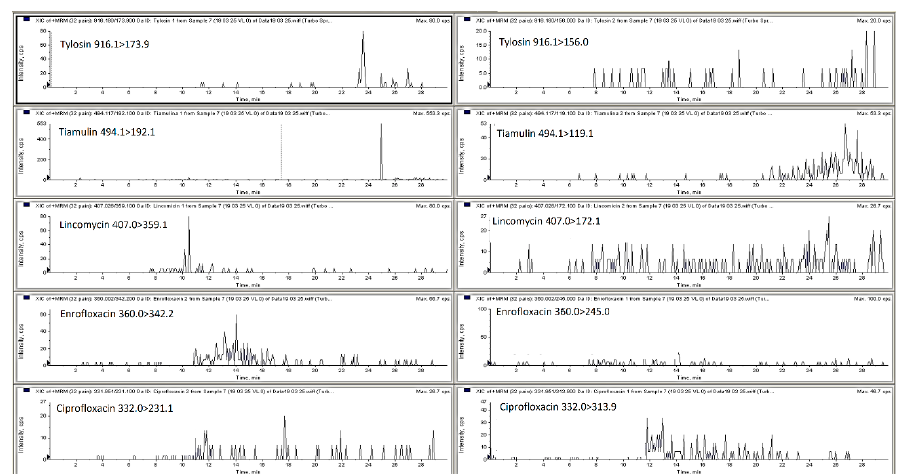
Figure 1. LC ‑ MS/MS MRM chromatograms of blank pig feces.